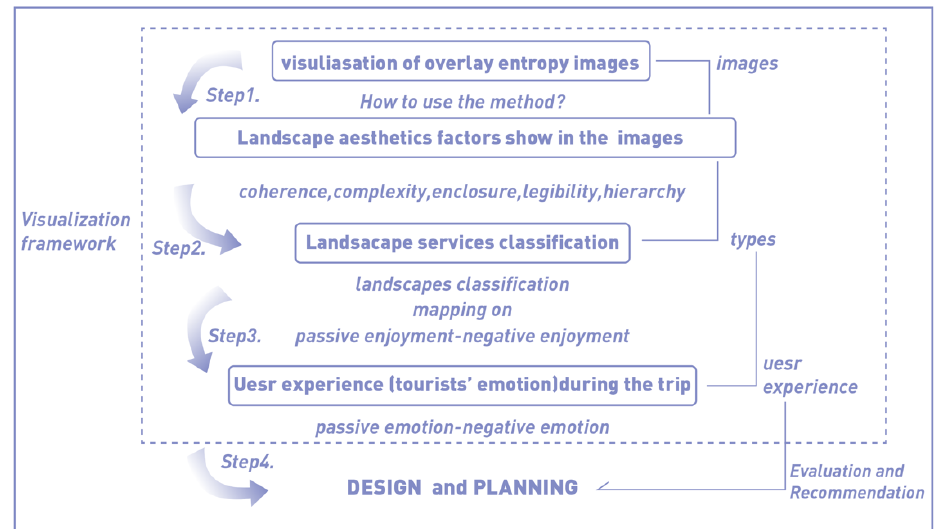
Figure 5. Flow table of the visualization method framework.